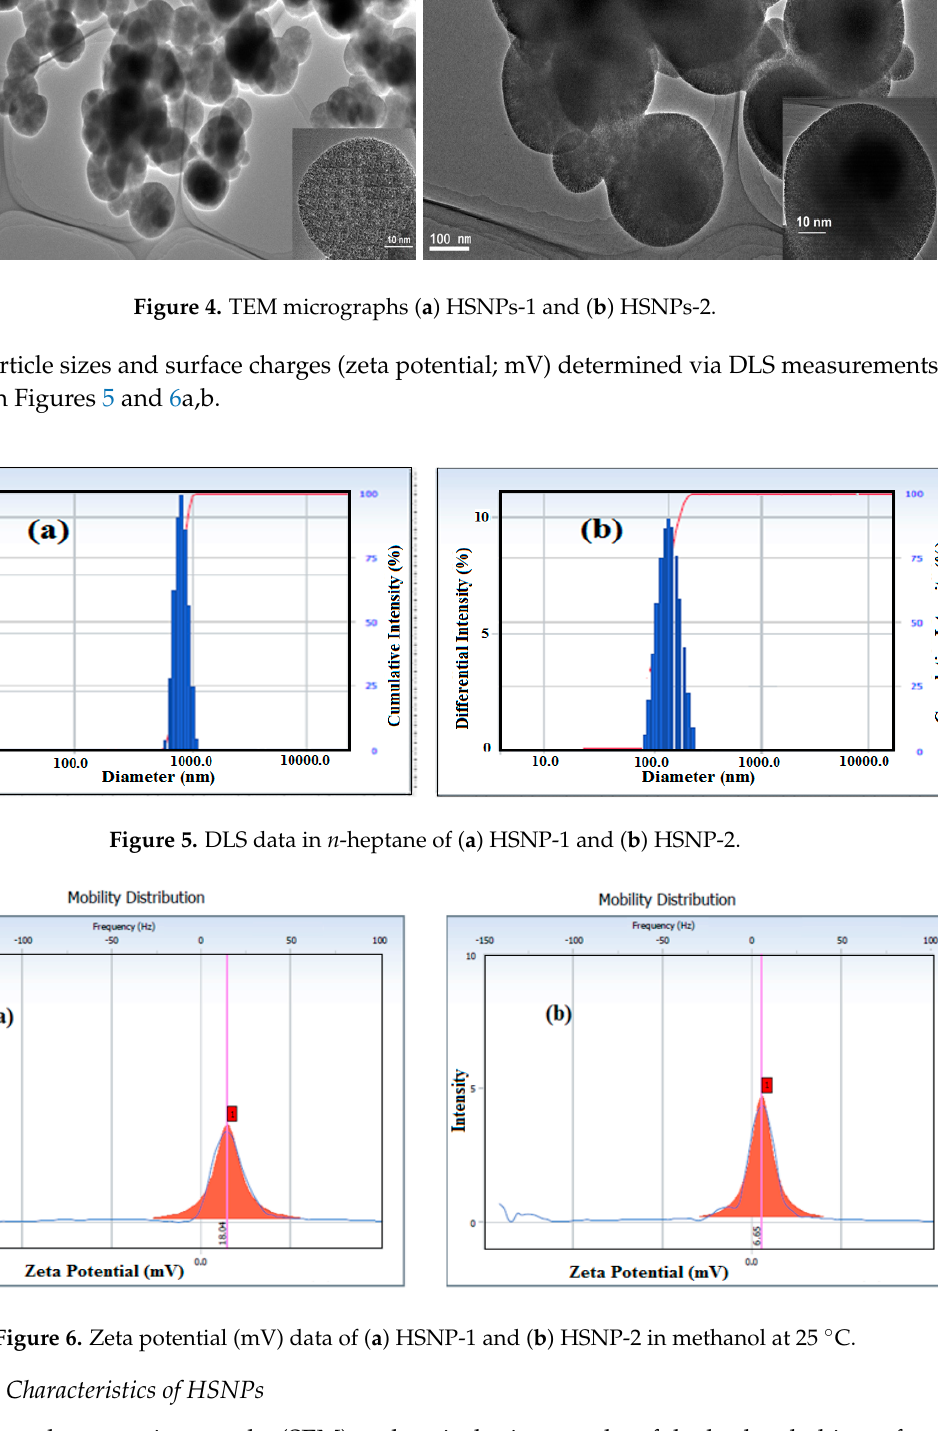
Figure 6. Zeta potential (mV) data of a ) HSNP-1 and b ) HSNP-2 in methanol at 25 °C.